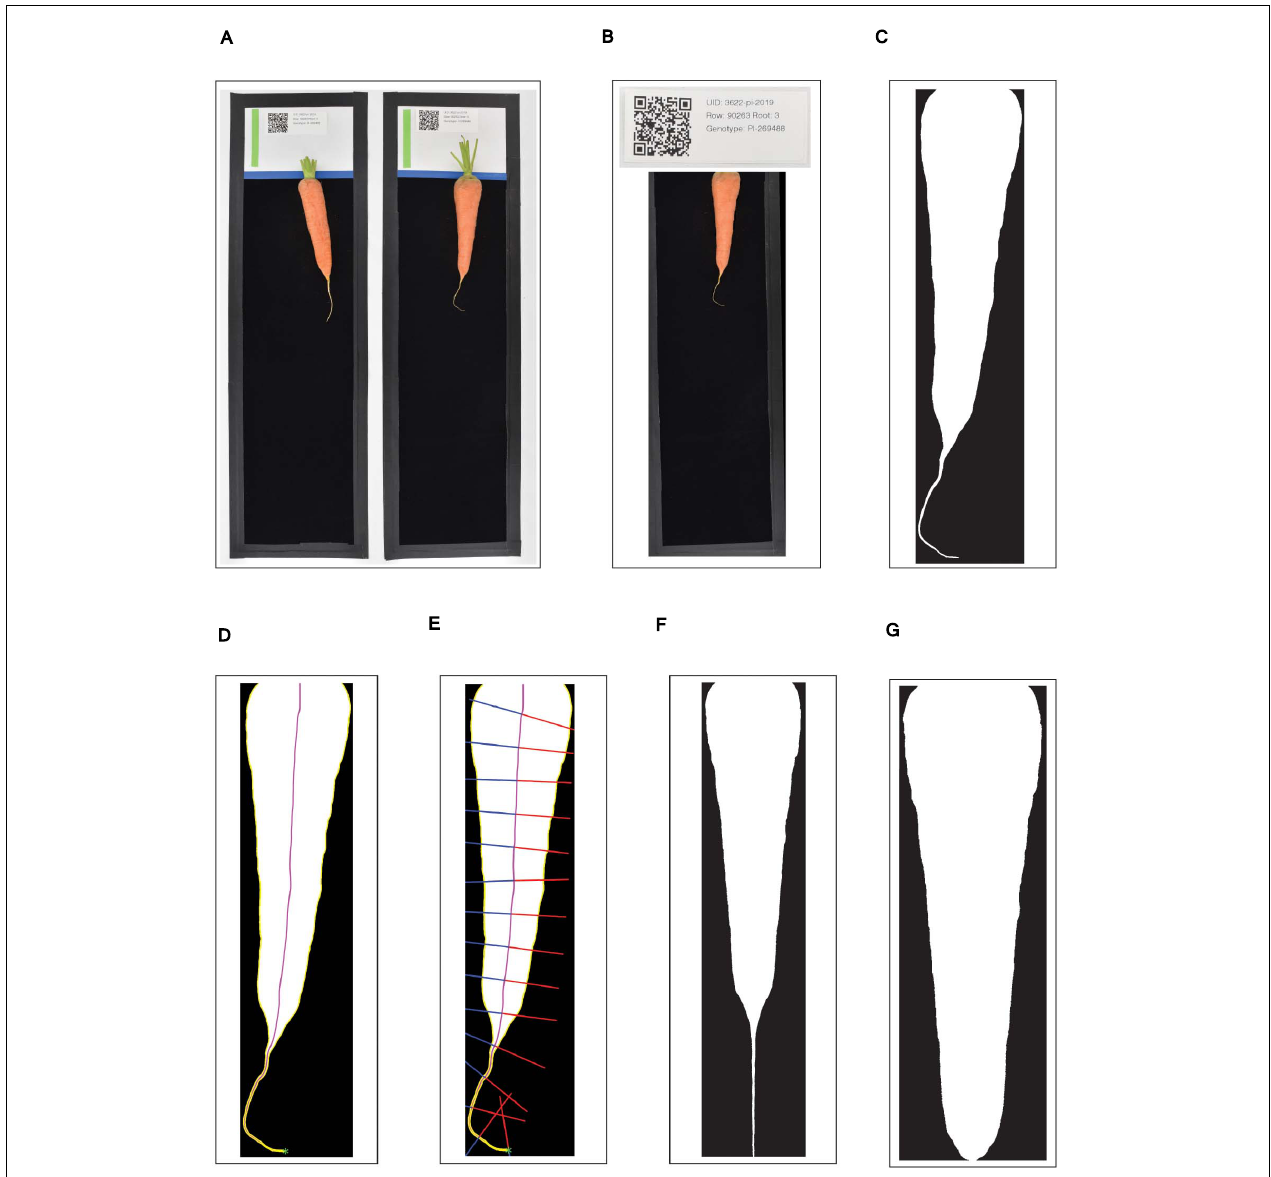
FIGURE 1 | Workflow outlining the pre-processing of digital images of carrot roots. (A) Each black-bordered box within the overall image are identified; (B) QR codes within the upper portion of each box are scanned and the encoded text is displayed as a form of quality control; (C) carrot pixels are distinguished from background pixels to generate binary masks; (D) the midline of the carrot root is estimated by tracing a path from the carrot tip to the center of the shoulder, following the maximum of the smoothed Euclidean distance transform; (E) width measurements are made by sampling the binary mask normal to vectors tangent to the midline; (F,G) A random forest classifier is used to detect the point at which to “de-tip” any residual, unexpanded tap